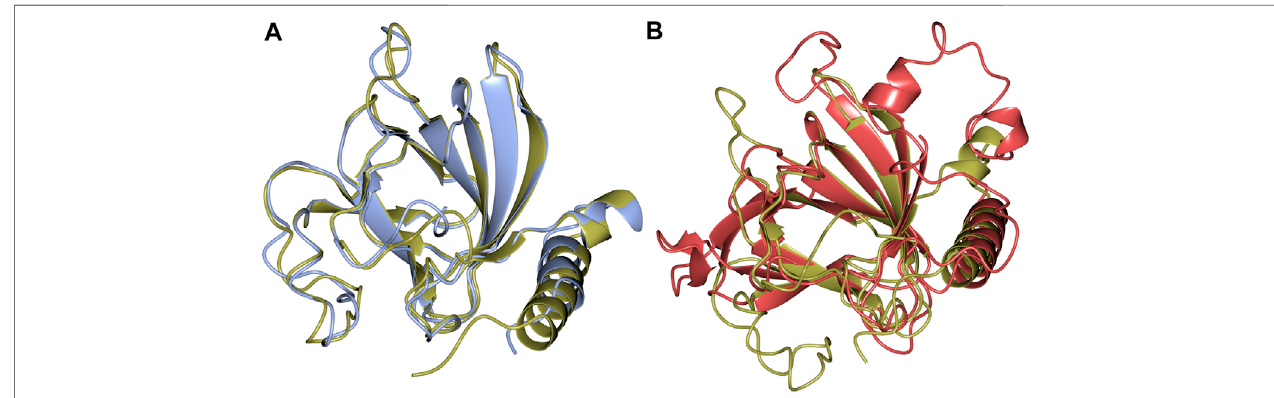
FIGURE8|(A) StructuralsuperimpositionofTsLI(gold)and B.subtilis (PDBID2Y0O,cyan),whichalignwithaRMSDof1.3 Åover169aaoutof171intotal. (B) Structural superimposition of TsLI (gold) to E. coli LI (PDB ID 3KMH, red), which align with a RMSD of 1.7 Å over151 aa.